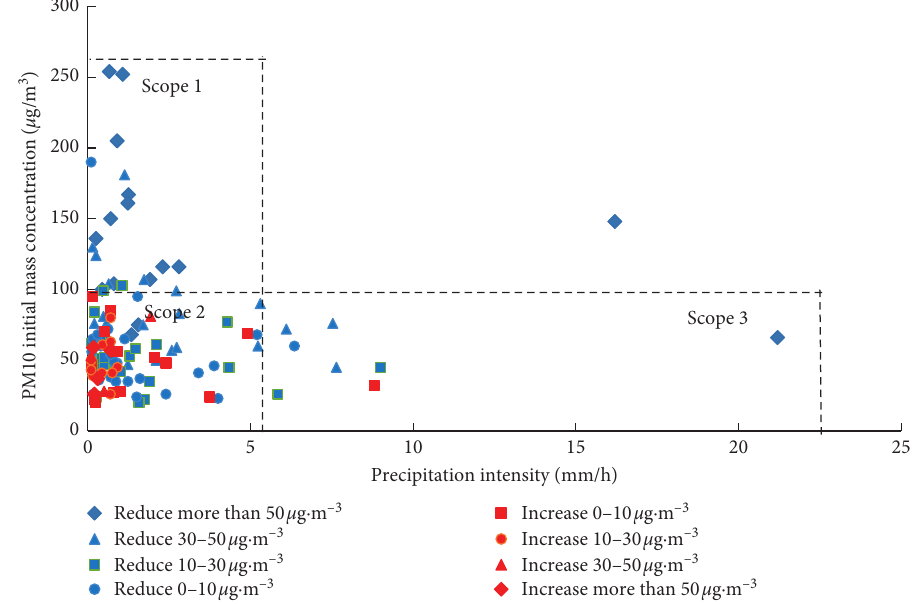
Figure 7: The relationship between PM10 mass concentration and precipitation intensity and initial mass